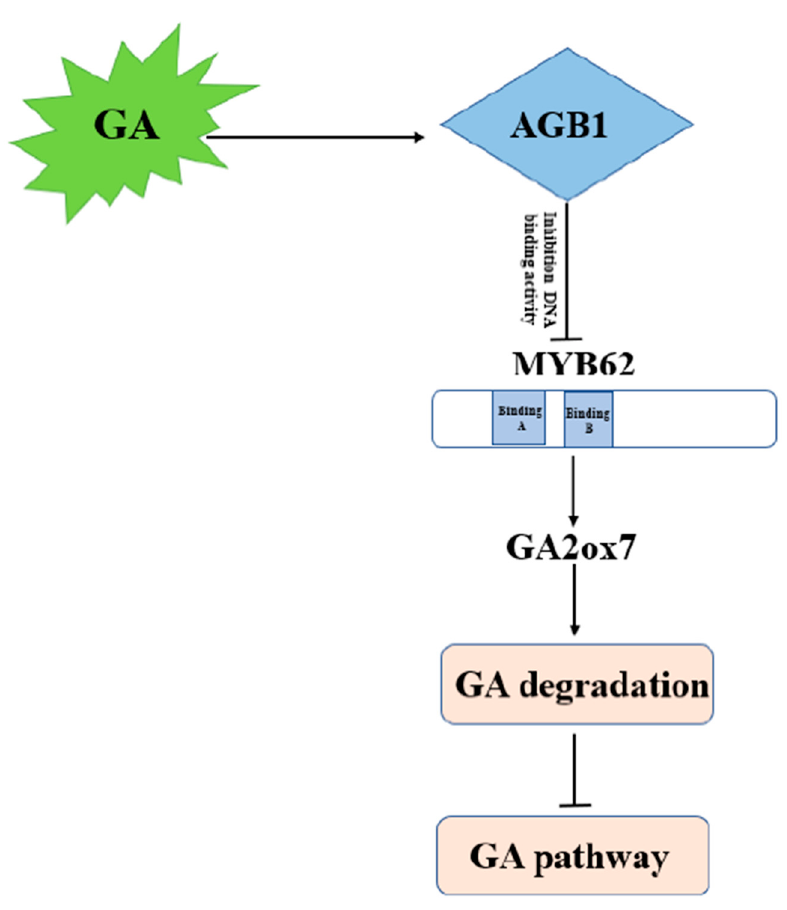
Figure 7. Model of how AGB1 regulates GA-related signaling pathways by controlling MYB62. This regulatory model shows the role of AGB1–MYB62 in regulation of the GA signaling pathway in Arabidopsis thaliana . AGB1 positively participates in the GA signaling pathway, interacts with the negative transcription factor MYB62, inhibits the binding of MYB62 to the promoter of GA metabo- lism related gene GA2ox7 , and negative regulates GA2ox7 expression.